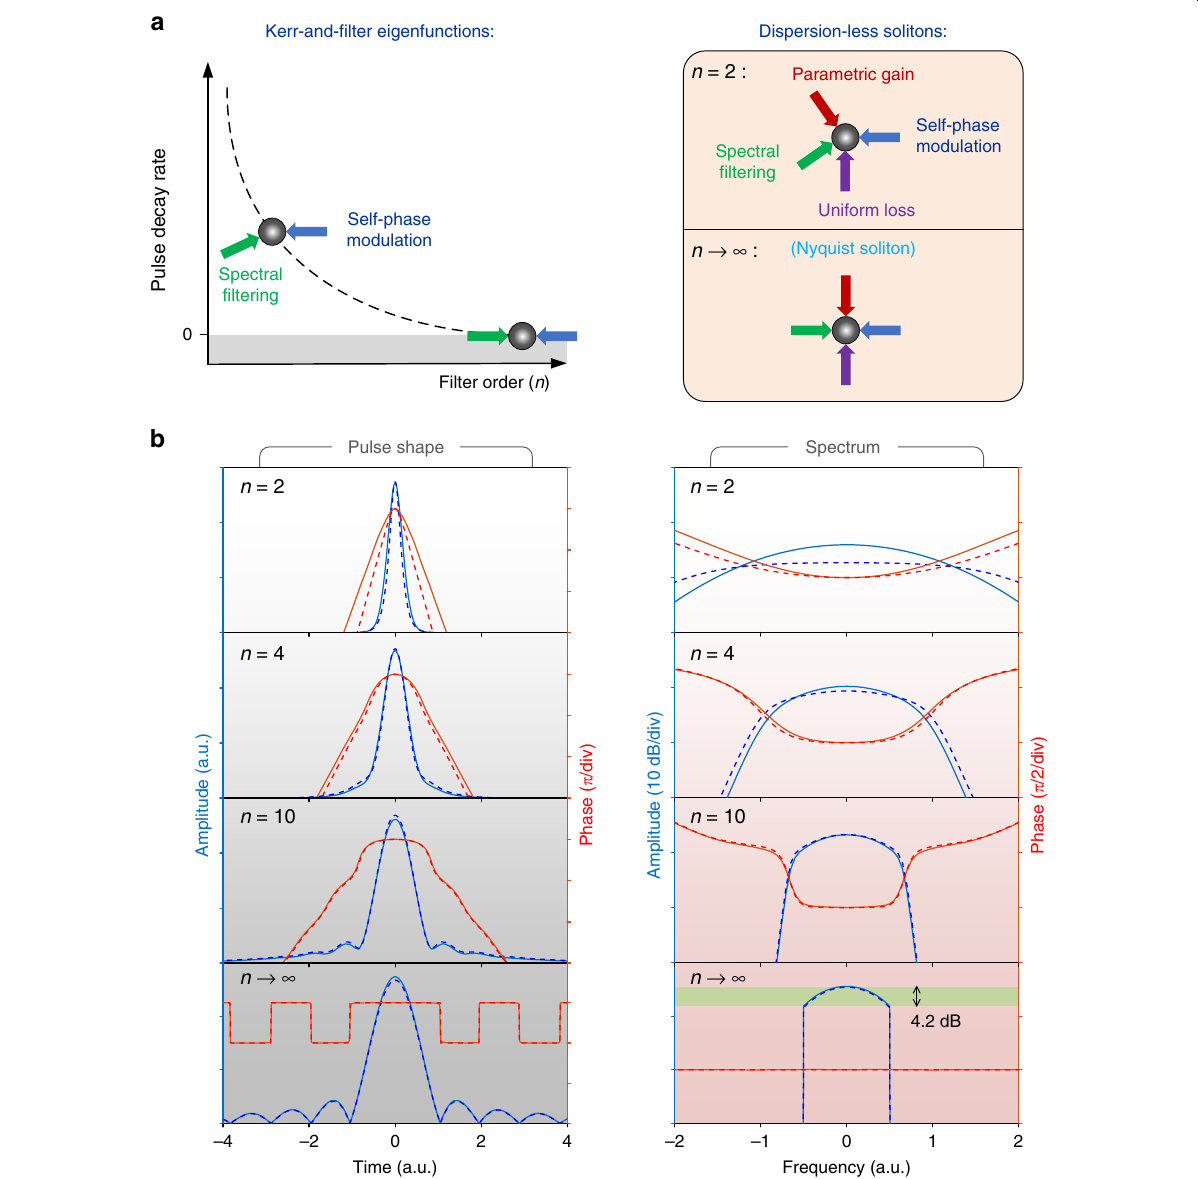
Fig. 1 Principle of the dispersion-less cavity soliton. a Schematic of the Kerr-and- fi lter eigenfunctions (left) and the dispersion-less stationary cavity solitons (right). The Kerr-and- fi lter eigenfunctions have a positive decay rate, which tends to zero when the fi lter order tends to in fi nity. Within a coherently pumped cavity, the parametric gain and uniform loss can achieve a composite balance to sustain dispersion-less cavity solitons whatever the fi lter order. When the fi lter order n ! 1 , a dispersion-less Nyquist soliton results from the double balance between spectral fi ltering and self-phase modulation on the fi rst hand, and parametric gain and uniform loss on the second hand. b Numerical results of the Kerr-and- fi lter eigenfunctions (dashed lines) and the cavity solitons (solid lines). Left, temporal amplitude and phase; right, spectral amplitude and